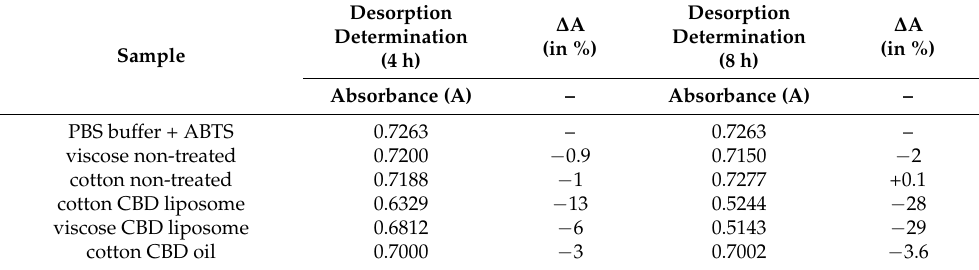
Table 5. The desorption results of non-treated, CBD liposome, and CBD oil functionalized cotton and viscose fibrous samples, obtained by 2,2 (cid:48) -azino-bis(3-ethylbenzothiazoline-6-sulfonic acid (ABTS) inhibition and electrical conductivity